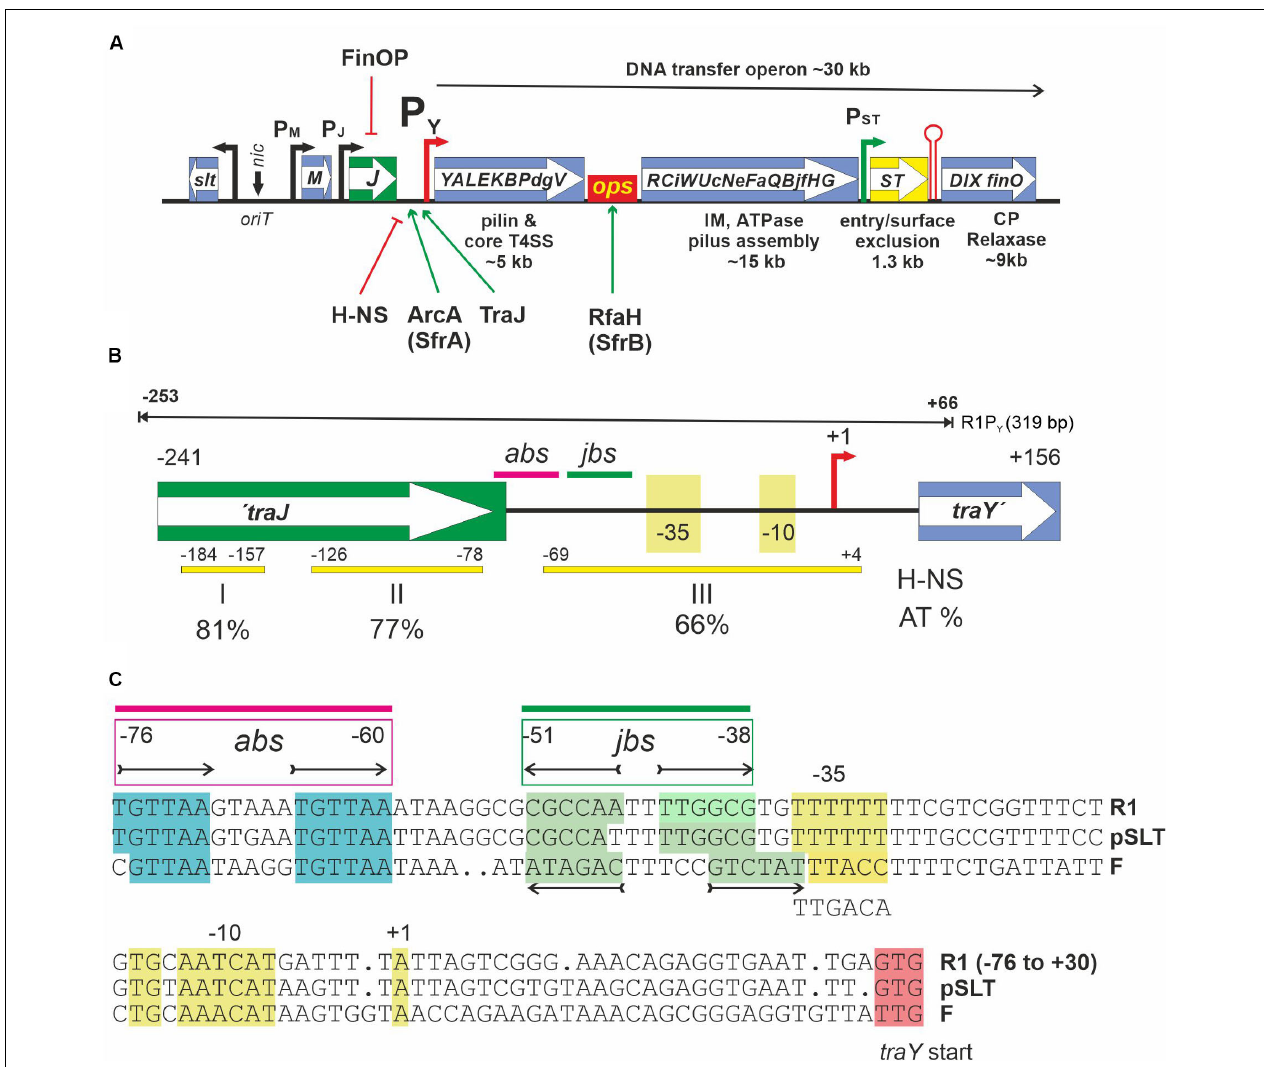
FIGURE 1 | (A) Schematic representation of the DNA transfer region of F-like MOB F12 A plasmids. DNA transfer ( tra ) genes are indicated by capital letters inside the boxes. oriT is the origin of DNA transfer, representing a DNA region where several DNA binding proteins such as TraM, TraY, and TraI (the relaxase-helicase) bind. nic denotes the nick site which is recognized by the relaxase for the initiation of ssDNA transfer into recipients via a T4SS. Arrows indicate known promoters. P Y is the only known promoter for transcription of the approximately 35 DNA transfer operon genes. It is regulated by the indicated host and plasmid encoded proteins. H-NS acts as a silencing factor whereas both ArcA (a.k.a. SfrA, host encoded) and TraJ (plasmid encoded) are needed for activation. Transcription of the complete operon additionally requires the host encoded anti-termination protein RfaH and its recognition site ops (operon polarity suppressor). Entry/surface exclusion genes traS and traT are constitutively transcribed in plasmid carrying cells. The transcriptional terminator (red hairpin) is functional only for transcripts initiating at promotor P ST . For a more in-depth discussion of DNA transfer genes and their regulation in MOB F12 A plasmids, the reader is referred to a recent review (Koraimann, 2018). (B) A schematic overview of the P Y promoter region of the MOB F12 A prototype plasmid R1 from − 241 to +156 relative to the transcription start site (+1, red arrow) of the tra operon is shown. This fragment is present in the promoter test plasmid pRSYZ4. Yellow bars with numbers indicating their location represent H-NS binding regions (I, II, III) as determined in this work. AT percentage of these regions is shown below. abs , binding site for ArcA; jbs , binding site for TraJ. These elements are also present on the 319 bp DNA fragment—termed R1P Y —used for EMSA and DNase I footprinting experiments (black line above). (C) Sequence representation of the P Y promoter of MOB F12 A plasmids R1 (KY749247), pSLT (AE006471), and F (AP001918). To access a complete plasmid sequence in the NCBI nucleotide database (https://www.ncbi.nlm.nih.gov/nuccore), please use the accession number provided in parentheses. The non-template DNA strand is shown. abs and jbs sites as determined in this work are given above the sequences for the plasmid R1 P Y promoter. The tandem repeat for ArcA binding [consensus: TGTTAA(N5)TGTTAA] is highlighted in cyan and the jbs inverted repeat sequences are highlighted in green. − 10, extended − 10 (TG), − 35 as well as the first transcribed nucleotide (+1) are highlighted in